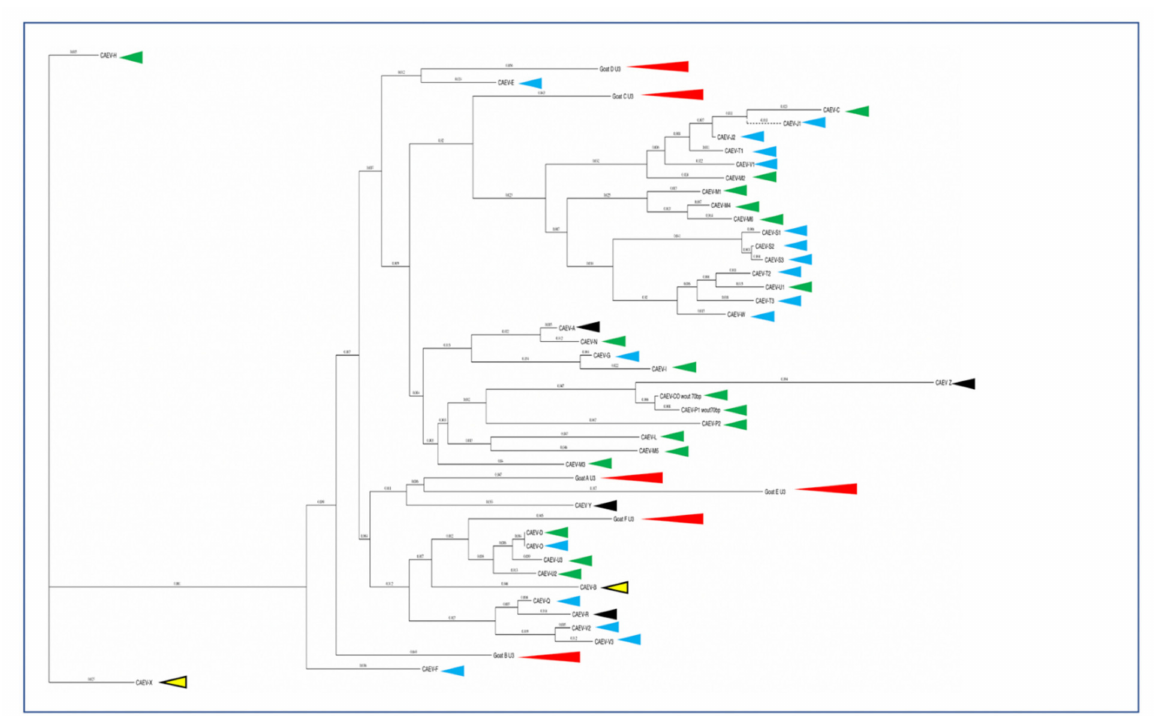
Figure 8. Phylogenetic dendrogram comparing the nucleotide sequences of CAEV U3 isolates from the renal tissue of goats A–E (red arrowheads) with previously published U3 sequences—tissues of the central nervous system (green arrowhead), joint synovium (black arrowhead), mammary gland (yellow arrowhead with black border) and lung (light blue arrowhead). CAEV A–Z sequences from [14]. Figure adapted with permission from BG Murphy, VM Elliott, N CVapniarsky, A. Oliver and J. Rowe (2010)